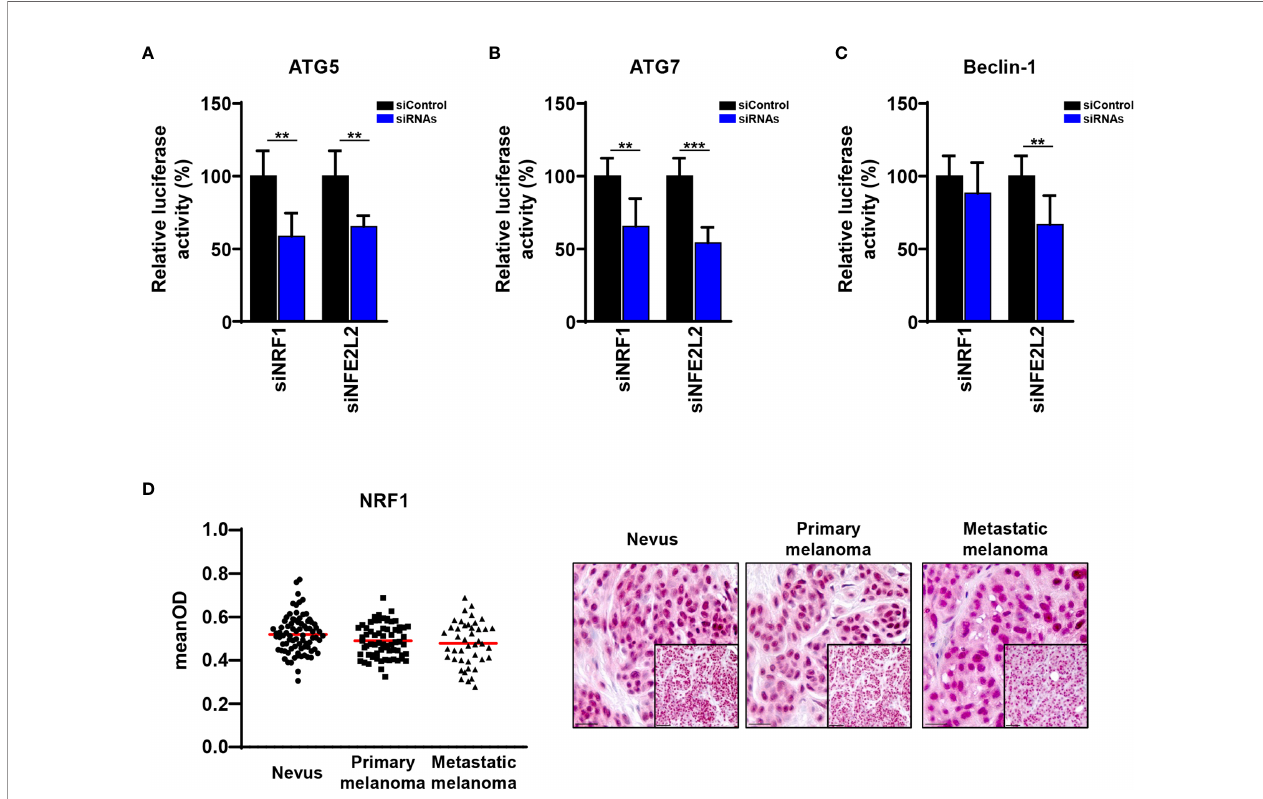
FIGURE 6 | Validation of NRF1 and NFE2L2 regulation of ATG5 , ATG7 and Beclin-1 promoter regions. (A – C) The Dual-Luciferase reporter plasmids (pGL4.74 [hRluc/TK] and pGL4.15[luc2P/Hygro]) were co-transfected with 50 nM siRNAs (Dharmacon) into SK-MEL-5 melanoma cells. 48 h post transfection cells were assayed for luciferase activity. The fi re fl y luciferase activities were normalized to renilla luciferase activity. The fi re fl y luciferase activity of the cells transfected with siRNAs is represented as the percentage of activity relative to that of the cells transfected with Non-Targeting siRNA (siControl). Statistical differences were analyzed by multiple t-test using the Holm-Sidak correction method (n=3). p ≤ 0.01**; p ≤ 0.001***. (D) Immunohistochemistry. Quanti fi cation of the NRF1 signal intensity in the nucleus. Intensity (mean optical density (meanOD)) values for individual patients are presented. The red lines represent the mean of all values. Statistical differences were analyzed by one-way ANOVA using a Kruskal-Wallis test and Dunn ’ s post hoc test (left panel). Representative images of 80 benign nevi as well as 67 primary and 43 metastatic melanomas are shown (right panel). Scale bars 20 m m (inlets) and 50 m